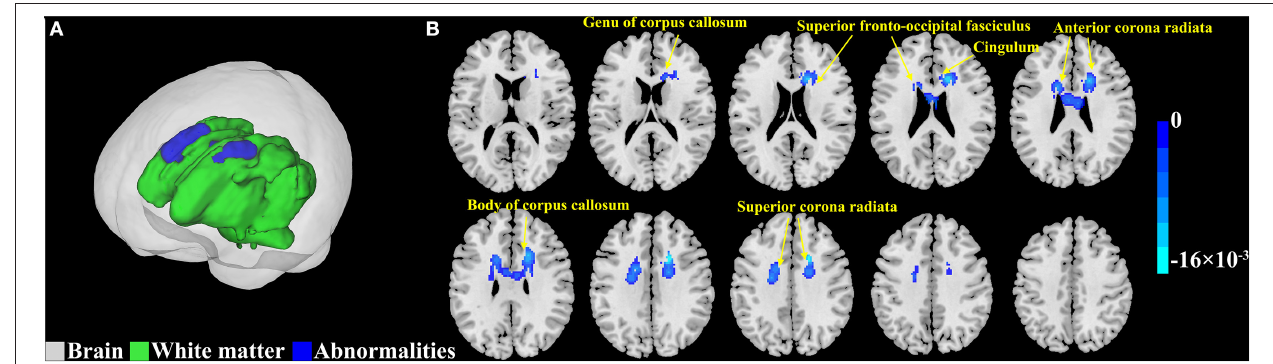
FIGURE 3 | Abnormal white matter estimated by fractional anisotropy (FA) in type 2 diabetes mellitus (T2DM). (A) The results from the activation likelihood estimation (ALE) meta-analyses are shown in 3D rendering. The gray region represents the outline of the brain. The green region represents the normal white matter. The blue region represents the abnormalities in the white matter. (B) The results from the ALE meta-analyses are overlaid onto a standard template in the Montreal Neurological Institute (MNI) space. The color bar represents the ALE value. Cluster-level inference threshold of P < 0.05 [family-wise error (FWE) correction] with 5,000 permutations and P < 0.05.